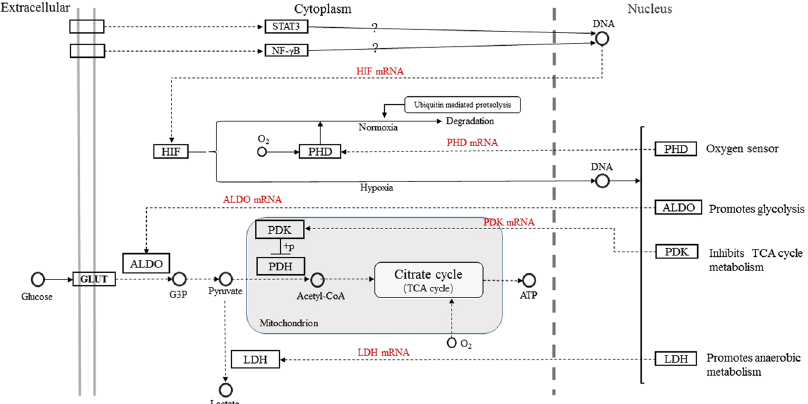
Figure 11. The partial regulation pathway of HIF (STAT3:signal transducer activator of transcription 3; NF- κ B: nuclear factor κ B; PHD: prolyl hydroxylase domains; HIF: hypoxia inducible factor; ALDO: fructose- biphosphate aldolase; PDK: pyruvate dehydrogenase kinase; LDH: lactate dehydrogenase; PDH: pyruvate dehydrogenase; G3P: glyceraldehyde 3-phosphate; GLUT: glucose